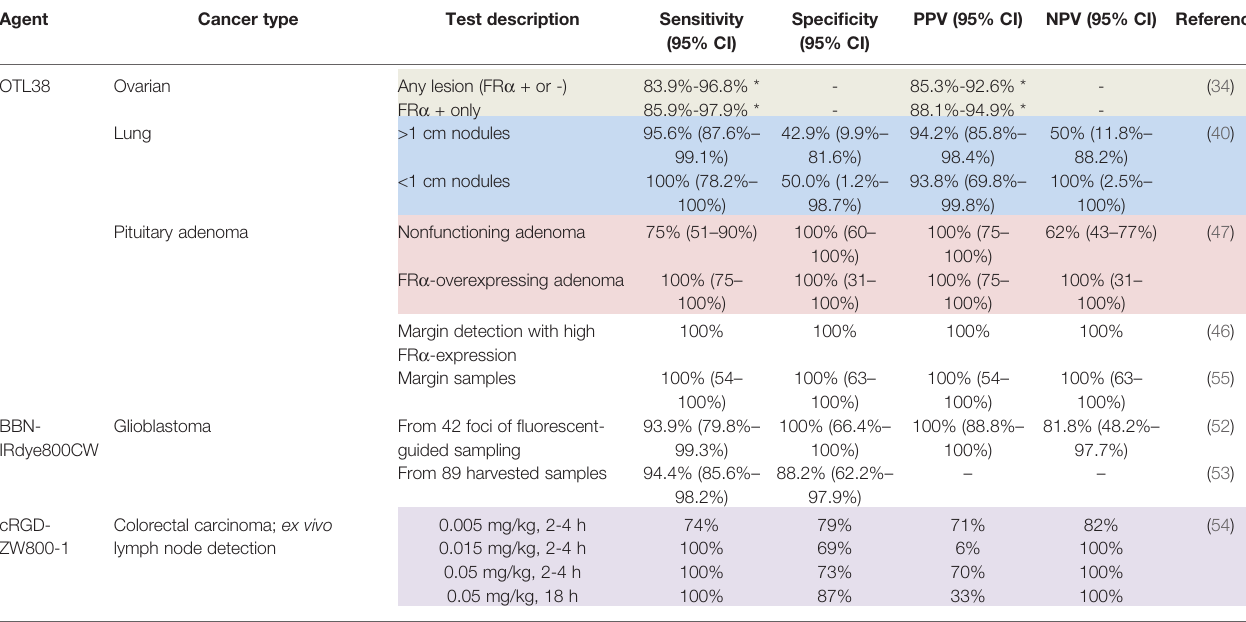
TABLE 2 | Diagnostic accuracy of LMW contrast agents in clinical